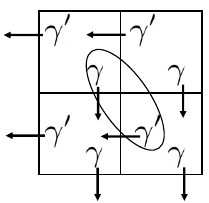
FIG. 17. To match our exact bosonization to Kitaev’s honey- comb model, we shift our Majorana modes on each face in the following way: (1) shift γ f downward and let it be γ on the new face; (2) shift γ (cid:7) leftward and let it be γ (cid:7) on the new face. f We re-pair γ and γ (cid:7) enveloped in the ellipse to form a complex fermion.